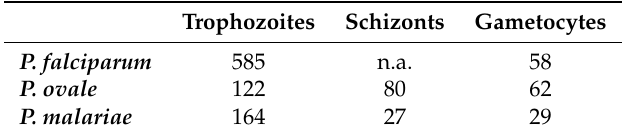
Table 1. MPs’ manual annotations by species and life cycle stage in the mThinMPs database.